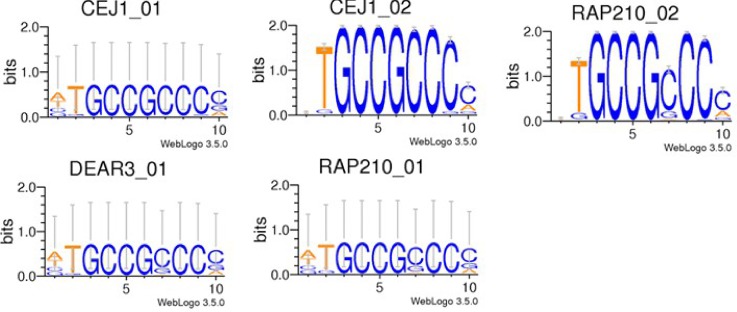
An example of five distinct TFBS entries in the TRANSFAC database with very similar position weight matrices (PWMs).